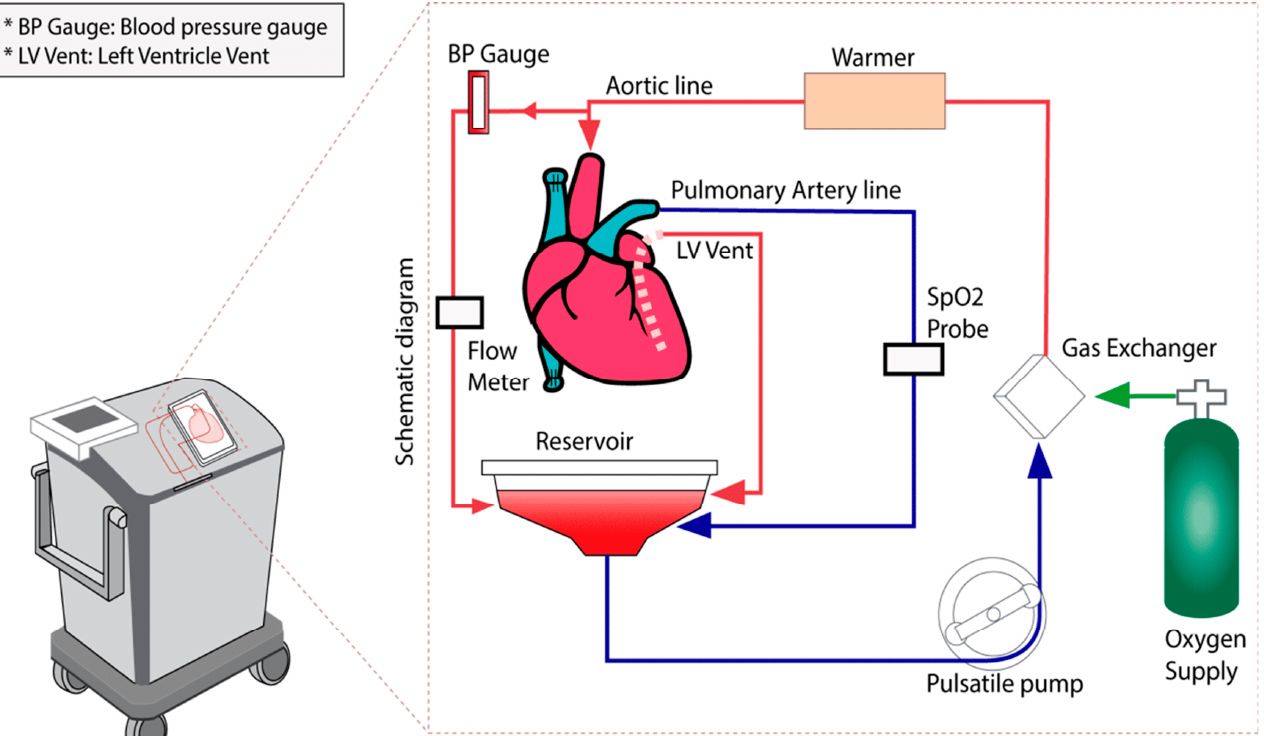
Figure 1. A schematic diagram of the blood flow through the Organ Care System (OCS) system. The blood enters the heart through the aortic cannula and travels retrogradely to the coronary arteries. Deoxygenated blood enters the coronary sinus and drains to the right atrium and right ventricle, where it is ejected out of the pulmonary artery and then drained to the reservoir. There is also a left atrial vent that drains to the reservoir. A pulsatile pump pushes the blood through a gas exchanger and a heater, where the cycle begins again. There is in-line sampling capability from the aortic line.